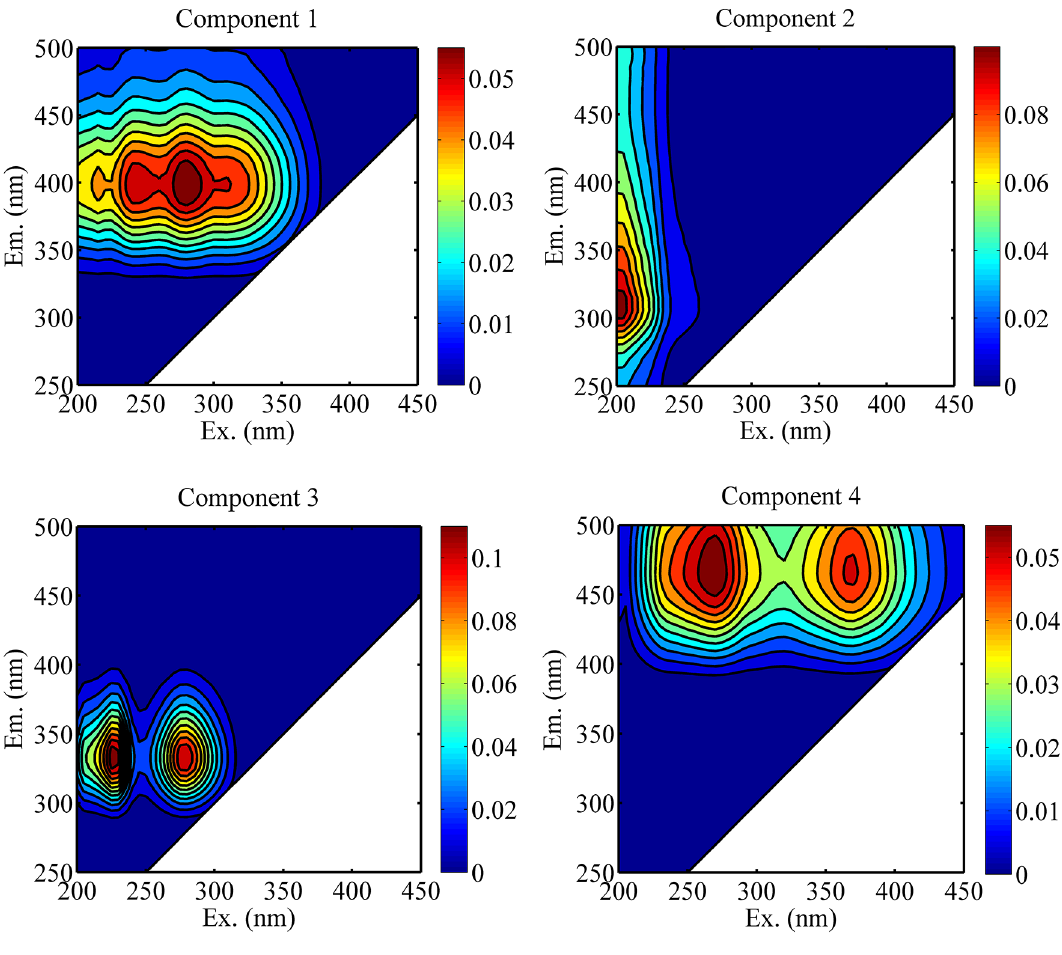
Figure 2: Four components of the three HAs identified by the PARAFAC